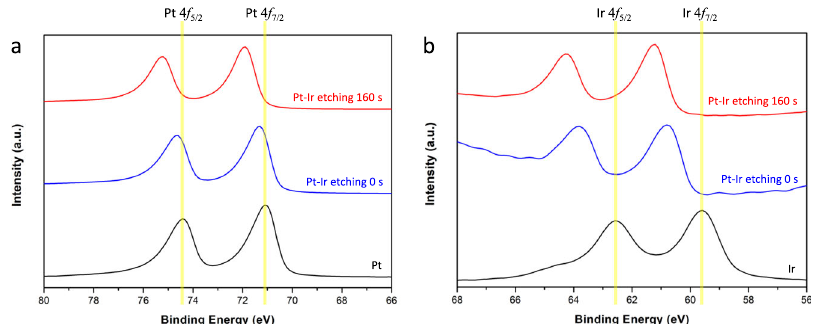
Fig. 3 XPS spectra of the electrodes. a , b Narrow-scan XPS spectra of Pt and Ir in the binding energy (BE) regions of Pt and Ir, respectively, compared to those of a fresh Pt-Ir 8 C alloy sample at different etching times of 0 and 160